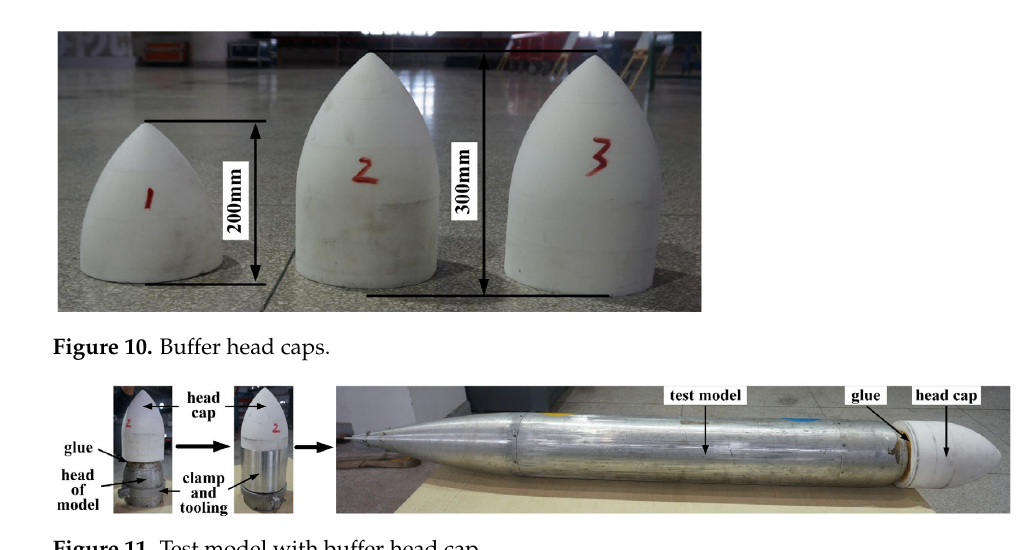
Figure 11. Test model with buffer head cap.